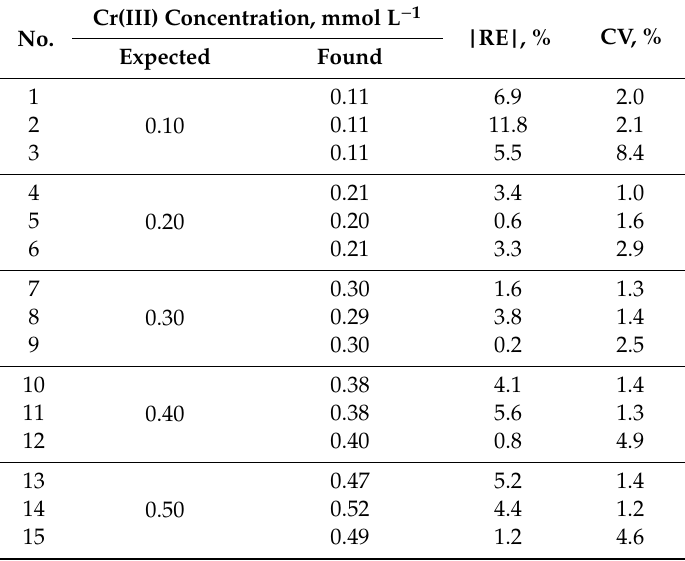
Table 2. Results of the determination of Cr(III) using the developed flow system ( n = 3).